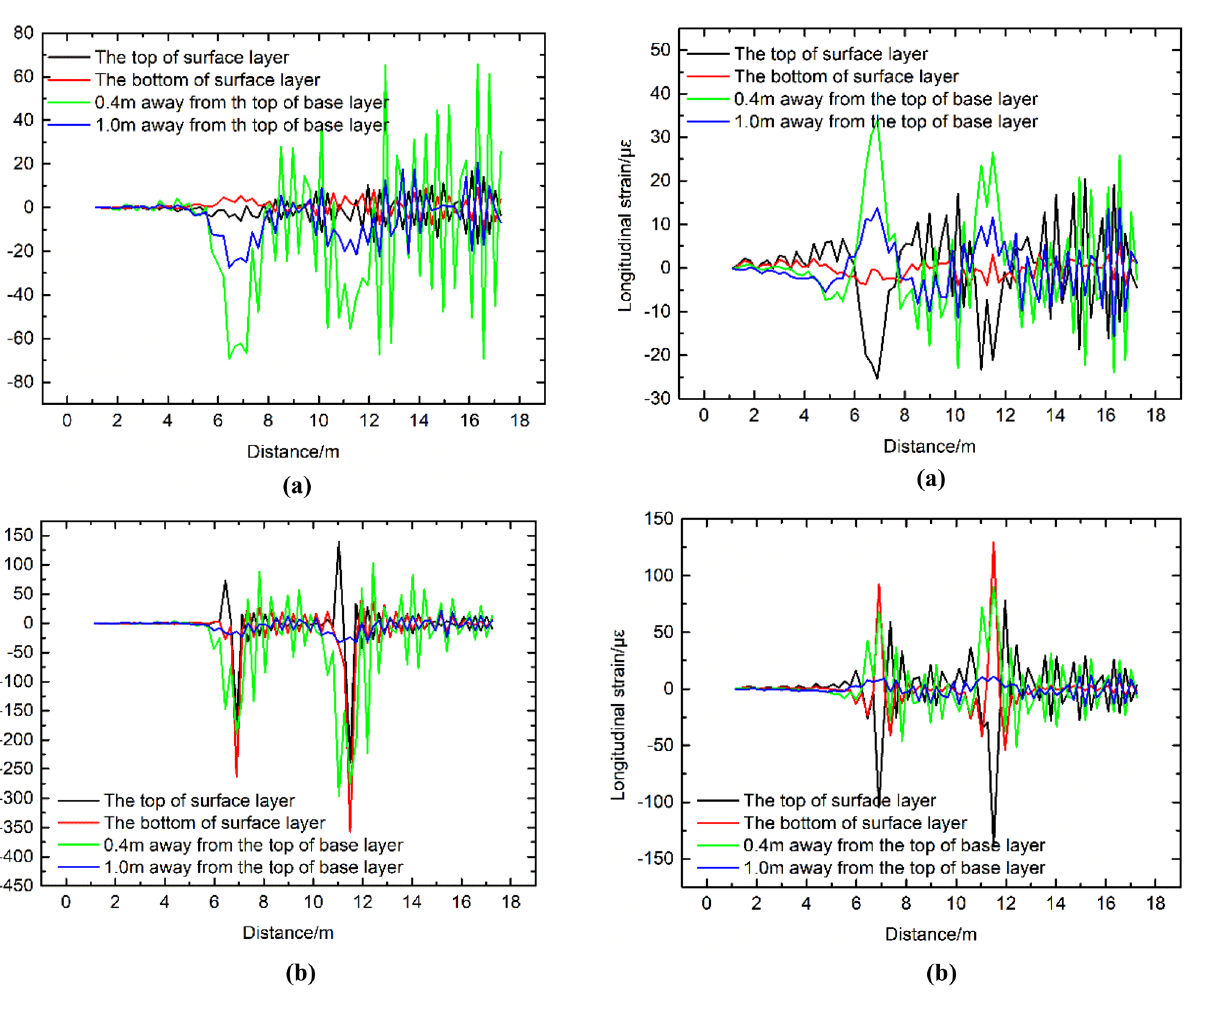
Fig. 4 Longitudinal strains of a the centerline of the two wheels and b under a single